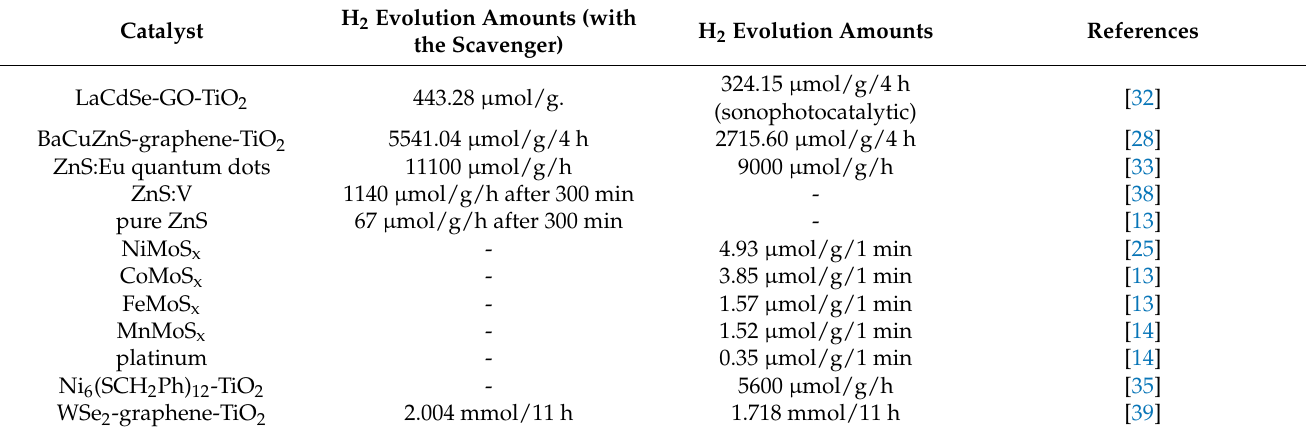
Table 1. H 2 evolution amounts of other catalysts have been